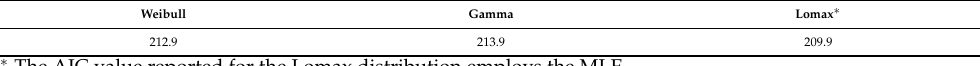
Table 7. The AIC values for the fitted distributions of the airborne communications transceiver